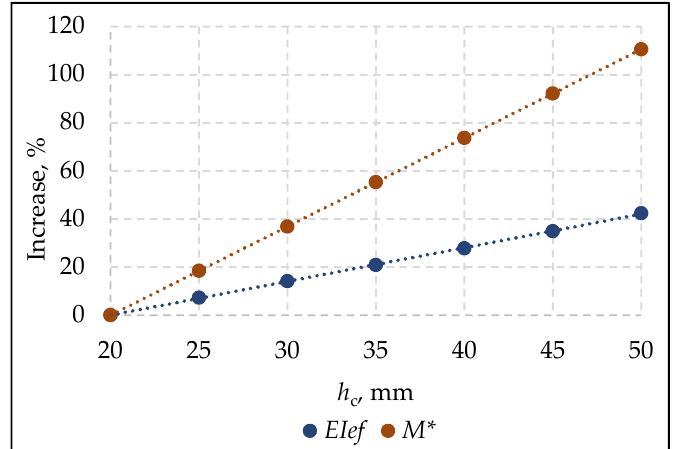
Figure 14. Increase bending stiffness EIef and modal mass M* dependence of concrete layer height h c for plywood–concrete with constant plywood panel cross-section parameters.